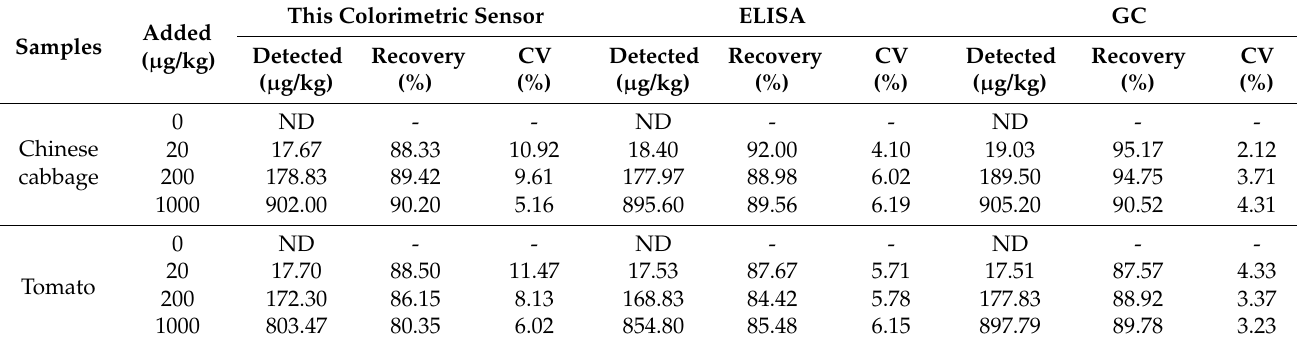
Table 1. Detection results of omethoate in Chinese cabbage and tomato ( n =